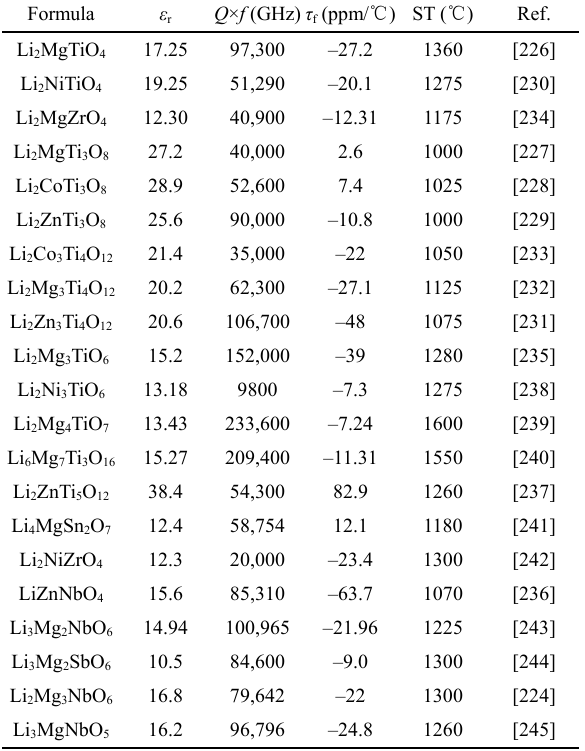
Fig. 8 Pseudo phase diagram of rock-salt structure. Microwave dielectric properties of pure phase with rock-salt